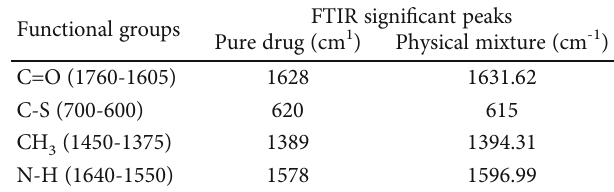
Table 2: FTIR compatibility